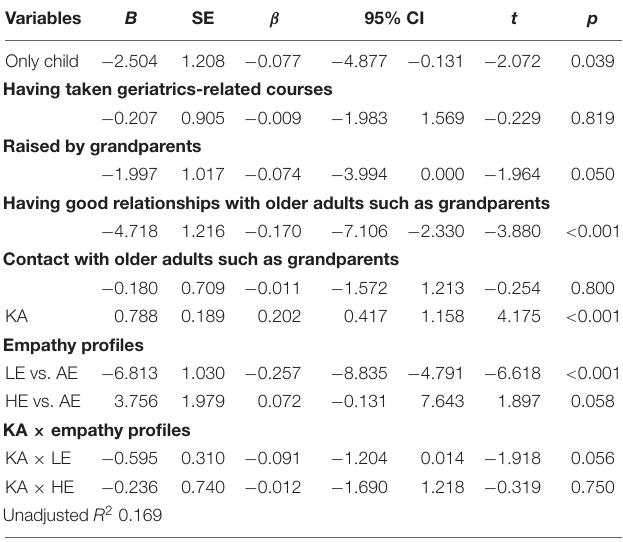
TABLE 6 | Regression analysis predicting KAOP + from KA and empathy profiles.